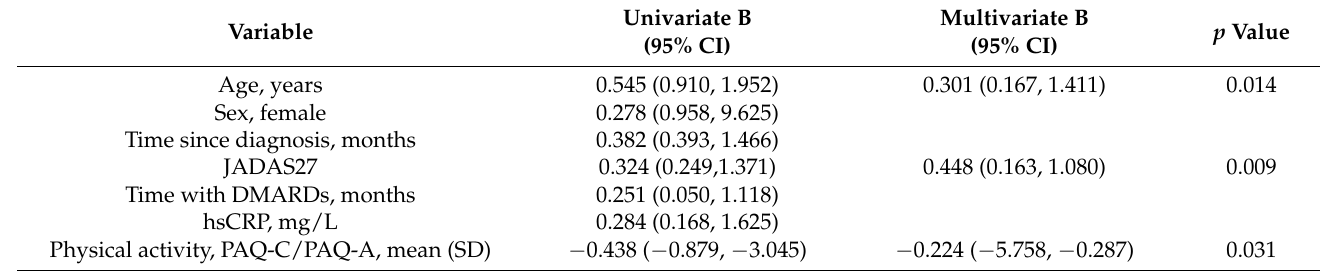
Table 4. Linear regression model of factors associated with FMI in patients with